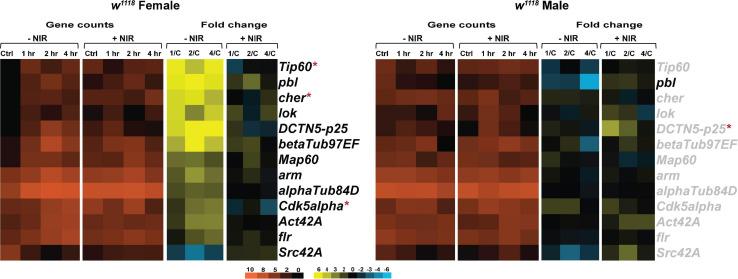
Cytoskeletal gene transcription is downregulated after NIR exposure. Heatmaps depicting cytoskeletal gene expression changes in w1118 females and males at control, 1, 2, and 4 hr after injury and NIR exposure. The orange scale represents average normalized counts for three replicates in each of the indicated groups. Yellow-blue scale shows fold change for each gene at 1-, 2-, and 4-hr post-injury compared to control. The genes indicated in black font are significantly changed in injured flies not exposed to NIR whereas red asterisk (*) indicates significant alteration in injured flies exposed to NIR (| log2FC| > 1, p-value < 0.05). 1/C: Fold change at 1 hr compared to control; 2/C: Fold change at 2 hr compared to control and 4/C: Fold change at 4 hr compared to control. (–NIR: not exposed to NIR and +NIR: exposed to NIR).